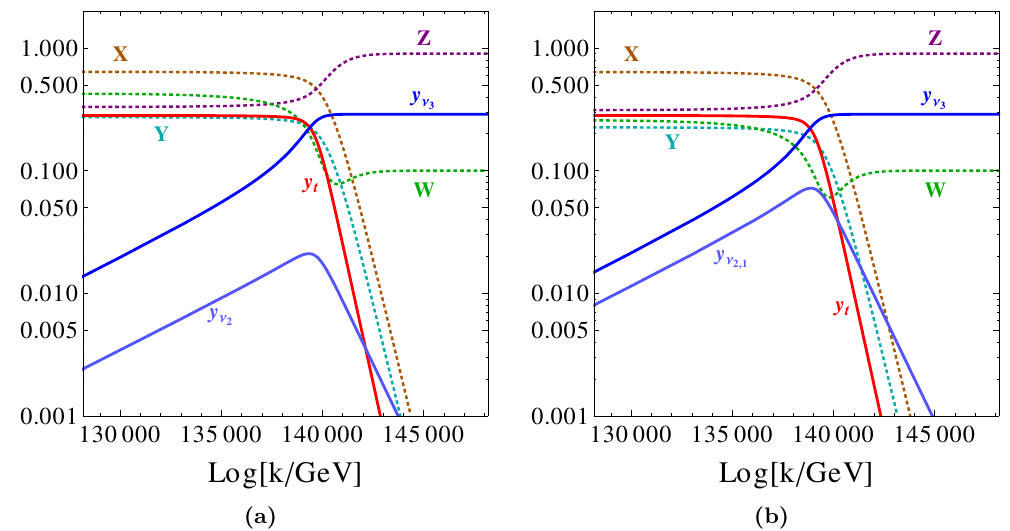
Figure 5. (a) RGE trajectories stemming from FP 5 of table 3, producing in the IR the neutrino Yukawa couplings given in eq. (2.7) and mixing parameters in agreement with eq. (2.14). (b) RGE trajectories stemming from FP , producing in the IR the neutrino Yukawa couplings given in 5 eq. (2.5) and mixing parameters in agreement with eq. (2.14). The AS gravity parameters are set at f = 0 . 0096 , f = 0 . 00025 g y